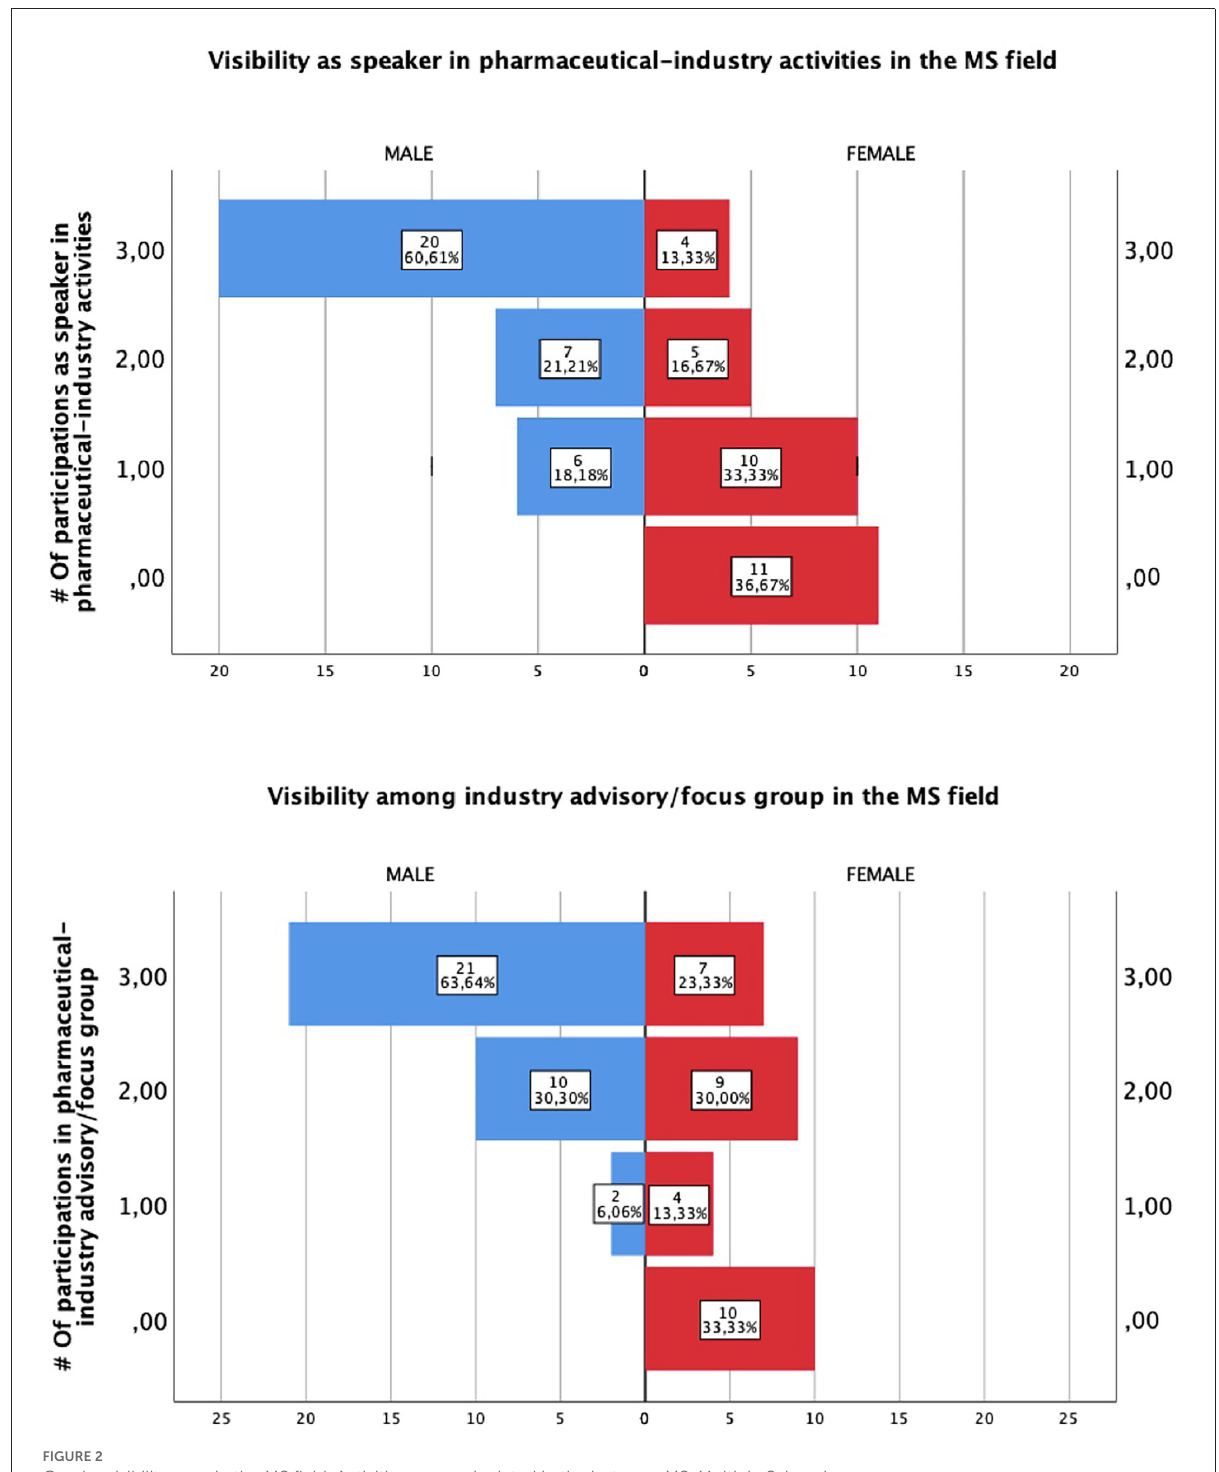
FIGURE2 Gender visibility gaps in the MS field. Activities were calculated in the last year. MS. Multiple Sclerosis.